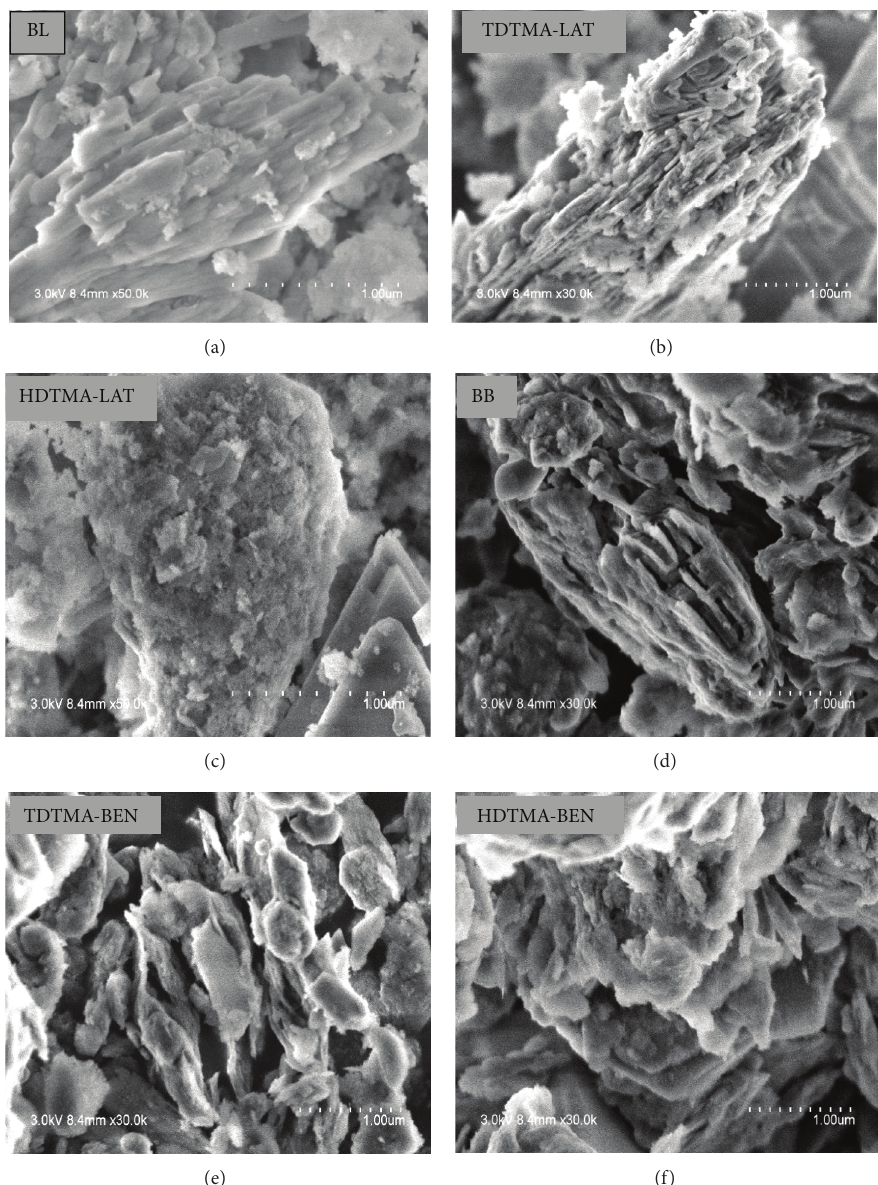
Figure 2: SEM micrographs of blank laterite (BL), TDTMA-LAT, HDTMA-LAT, blank bentonite (BB), TDTMA-BEN, and HDTMA-BEN (left to